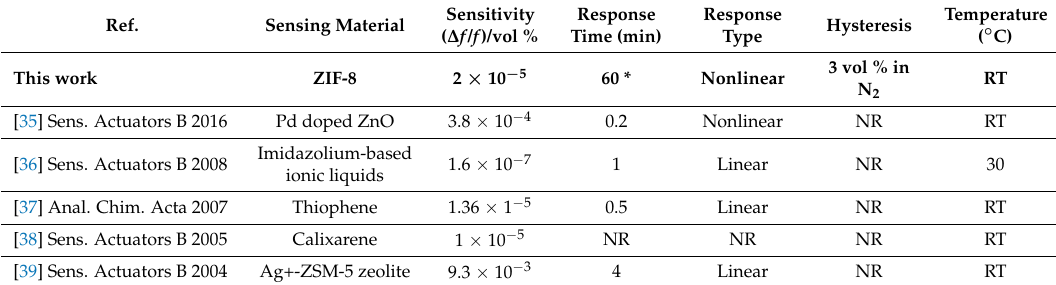
Table 4. Comparison of the previously reported QCM transduction-based acetone sensors.